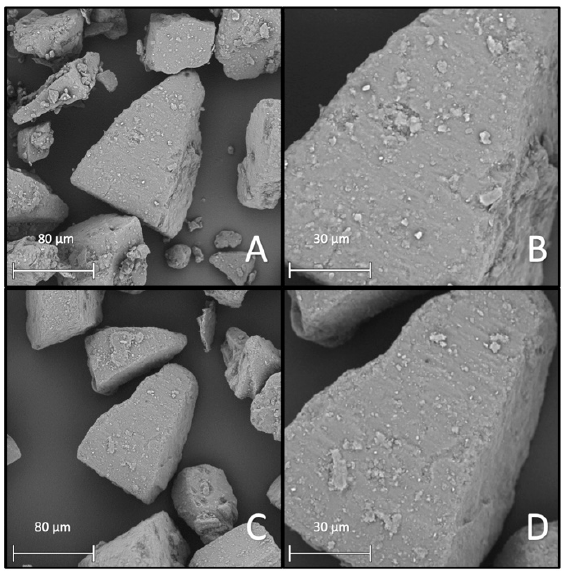
Figure 6. SEM images showing IH230HSM+. ( A , B ) Before and ( C , D ) after removing residual parti- cles via air-jet sieving. ( A , C ) In 1000× magnification and ( B , D ) in 2500×